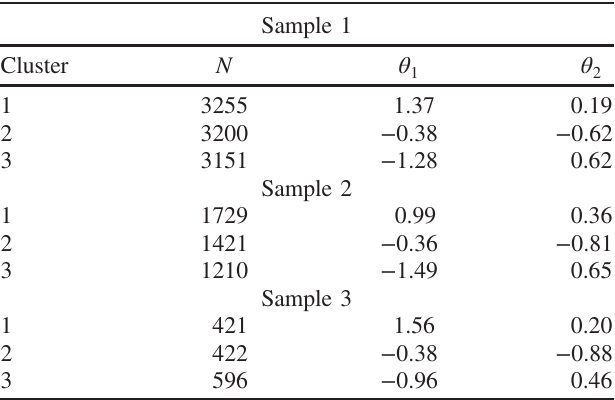
TABLE III. Cluster centers for each